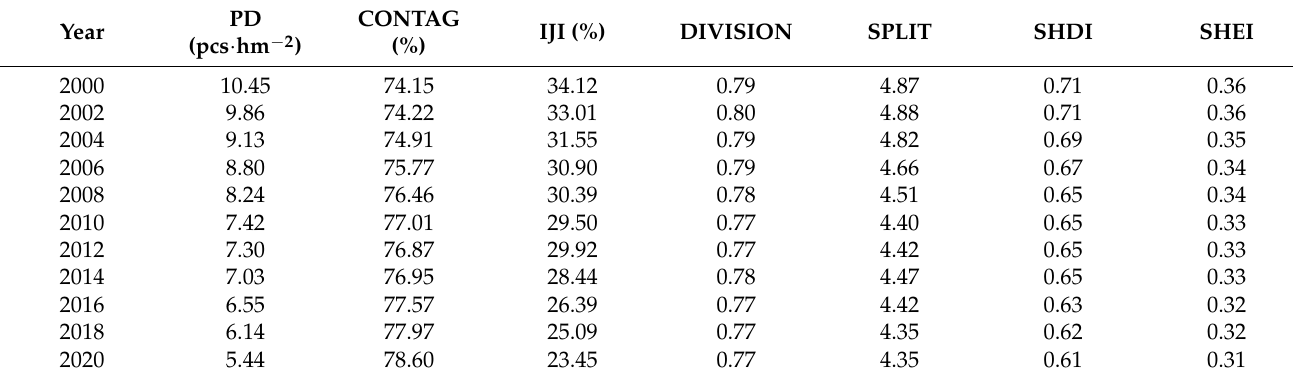
Table 5. Landscape-level index.